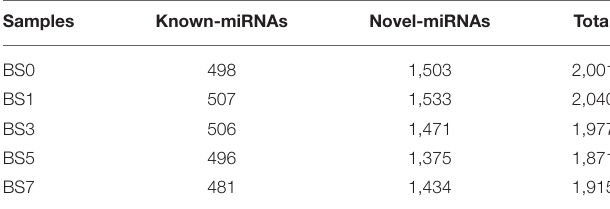
TABLE 3 | Results of miRNA identification for each